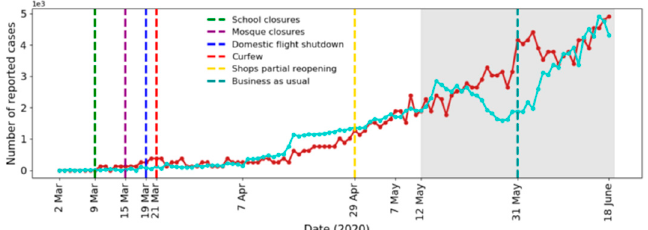
Figure 5. Actual (blue) and simulated (red) number of recorded cases per day. Shaded region: actual (blue) and predicted (red) number of recorded cases for the period 12 May 2020 to 18 June 2020.